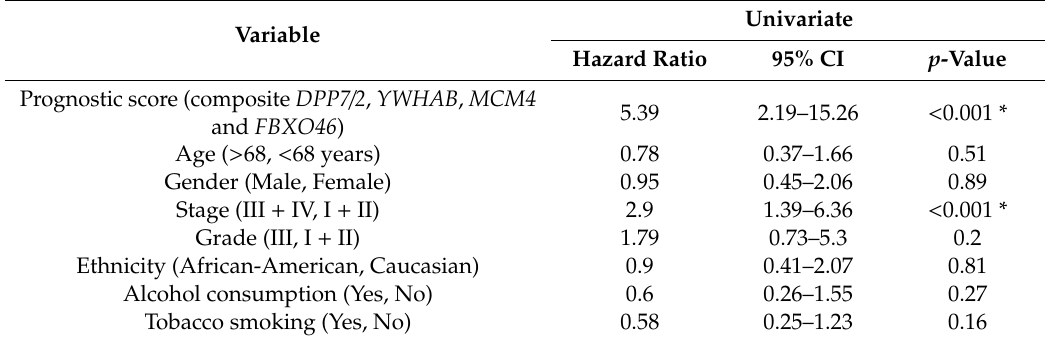
Table 4. Univariate Cox regression analysis of prognostic score and other clinicopathological variables.